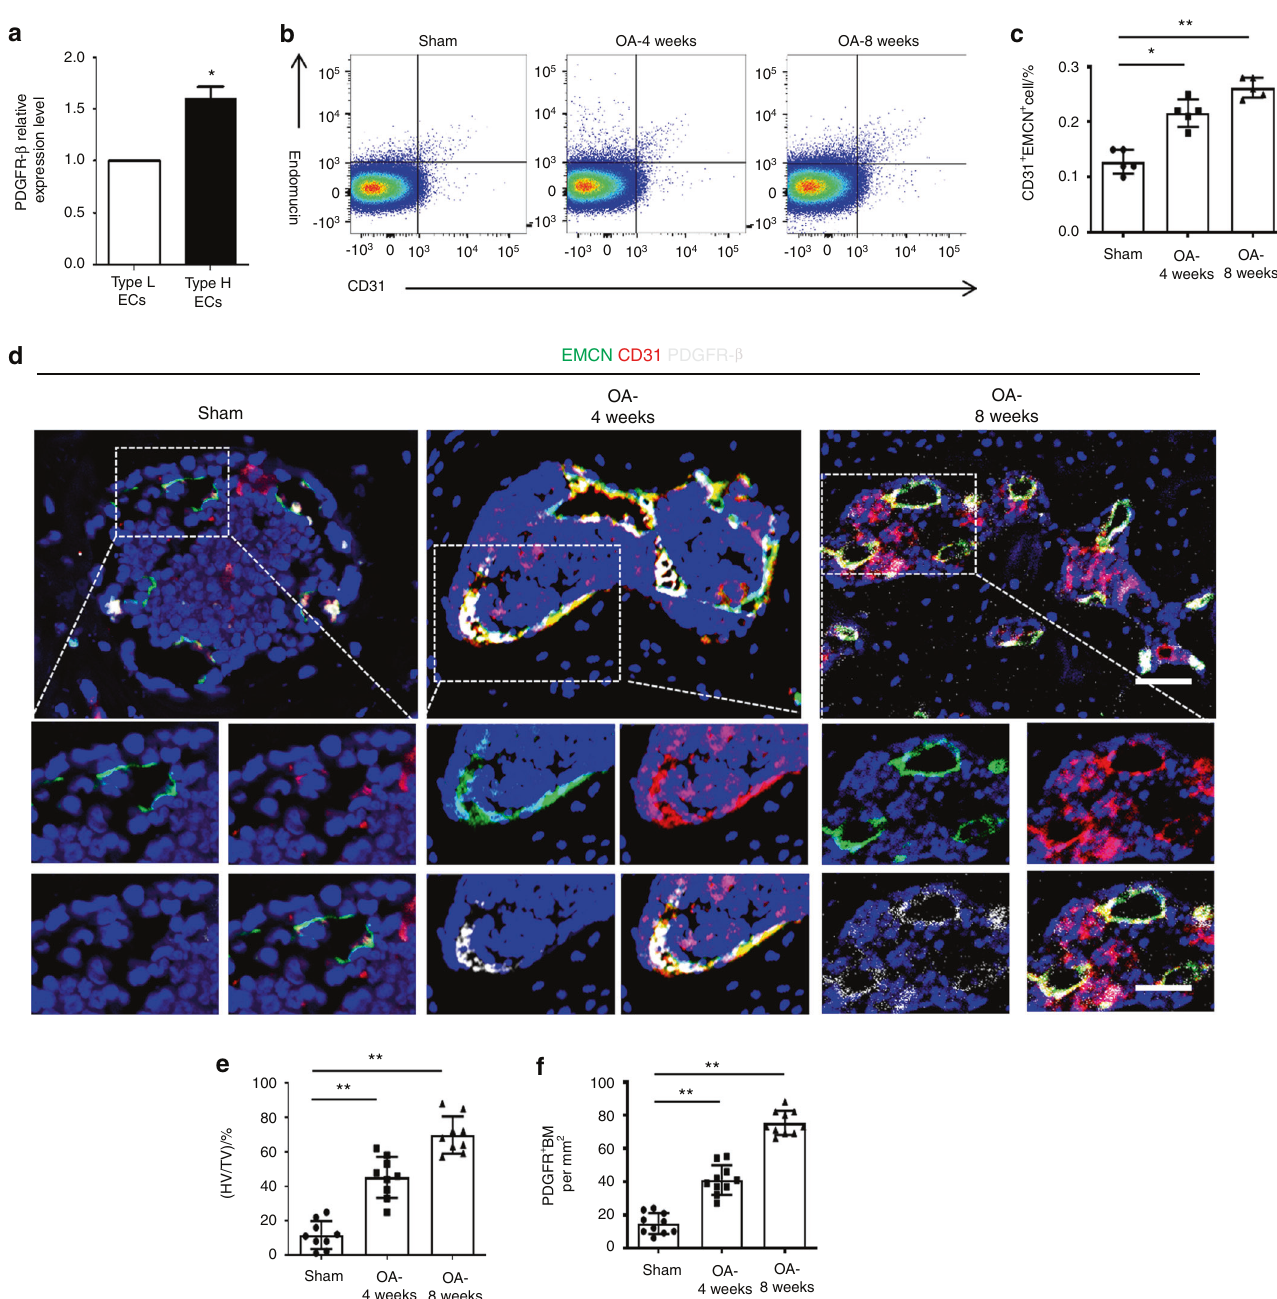
Fig. 2 PDGFR- β is primarily expressed in CD31 hi Emcn hi endothelial cells (ECs). a qRT ‒ PCR examination of PDGFR- β in CD31 hi Emcn hi ECs and CD31 lo Emcn lo ECs of bone marrow from normal mice. FACS analysis ( b ) and quanti fi cation ( c ) of CD31 hi Emcn hi ECs isolated from the bone marrow of the sham and 4-week-old and 8-week-old ACLT groups. n = 5 (5 mice with 10 subchondral bone specimens). d Confocal images (upper) with the magni fi ed area (bottom) in the boxed area in the upper image of H-type vessels (endomucin: green; CD31: red; merge: yellow) and PDGFR- β + cells (white) of the sham and 4-week and 8-week post-ACLT groups. Scale bar, bottom 50 µm; top 100 µm. e , f Quanti fi cation of H-type vessel volume and PDGFR- β + cells in the sham and 4-week and 8-week post-ACLT groups. n = 10. Sham = sham controls. TV = total vessel volume; HV = H-type vessel volume. * P < 0.05 and ** P < 0.01 compared to the sham group or as denoted by FAK were selected for further study (Fig. 5a, b). The binding of spectrometry (LC ‒ MS/MS) analysis to detect PDGFR- β -interacting PDGFR- β , talin1, and FAK was con fi rmed through IP assays, as proteins in BMECs. Table 1, 2. A total of 1553 PDGFR- β -binding demonstrated by the puri fi ed complex of PDGFR- β /talin1/FAK, proteins were identi fi ed in the BMECs with or without PDGF-BB suggesting that talin1 and FAK are potential binding partners of treatment (Table S1). Among these candidates, talin1 showed the PDGFR- β (Fig. 5c). As expected, the binding of PDGFR- β , talin1 and largest change (25-fold increase) with PDGF-BB treatment FAK was stronger with PDGF-BB treatment. Next, we tested compared to PBS treatment. FAK is considered a key partner for whether the PDGFR- β /talin1/FAK complex was activated by PDGF- talin1-regulated vessel formation. 42 A 2-fold increase in FAK was BB. Western blot assays revealed that phosphorylation of talin1 also observed in the BMECs treated with PDGF-BB. Thus, talin1 and